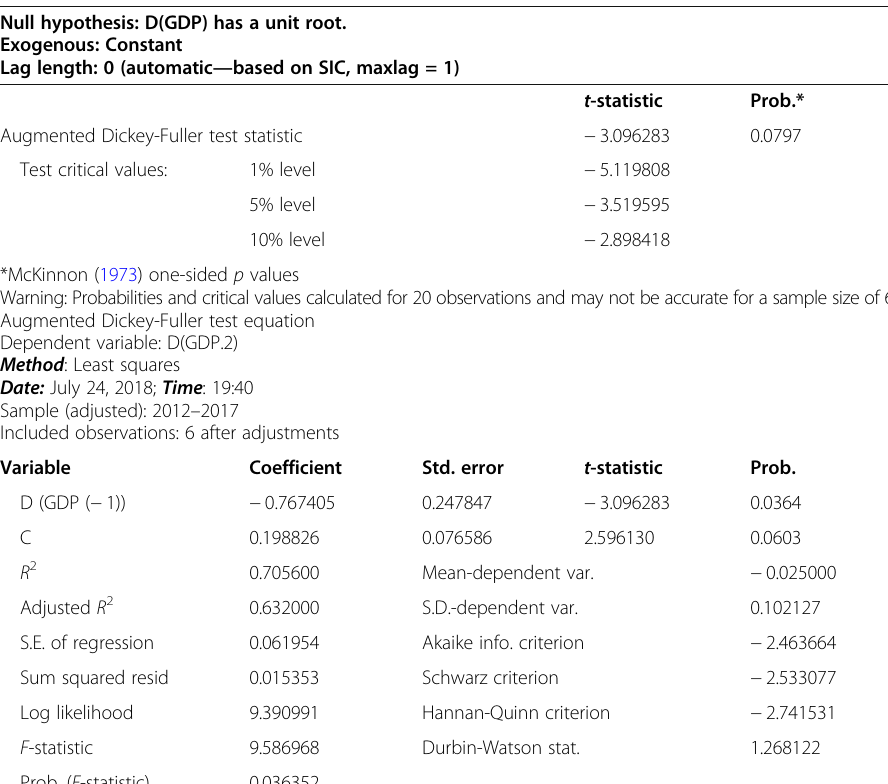
Table 3 ADF test for the first